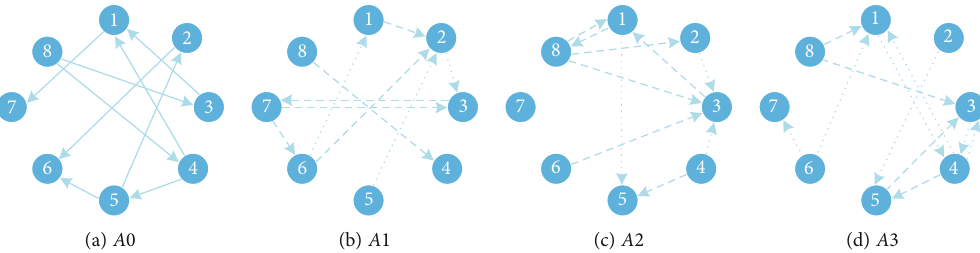
Figure 7: Topology of the multilink complex networks in Example 2 with eight nodes and four